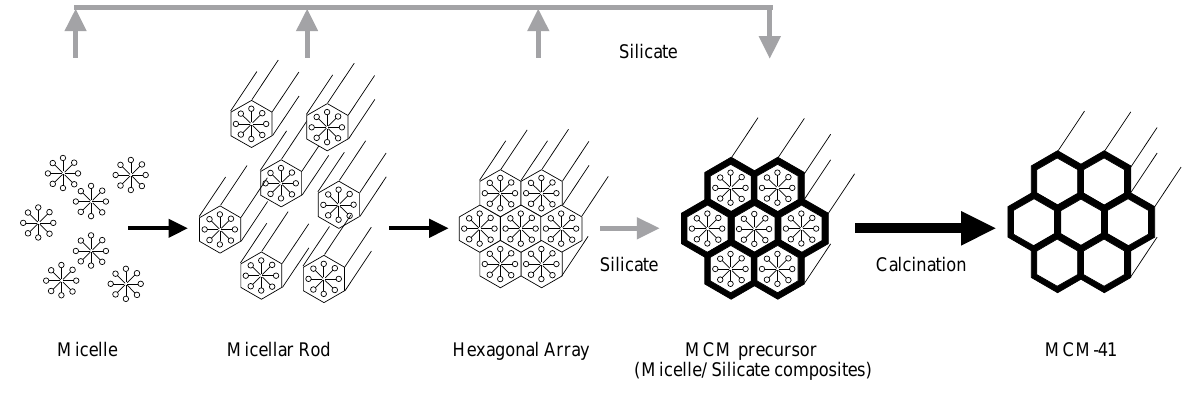
Schematic model of MCM-41 synthesis (modified from Beck